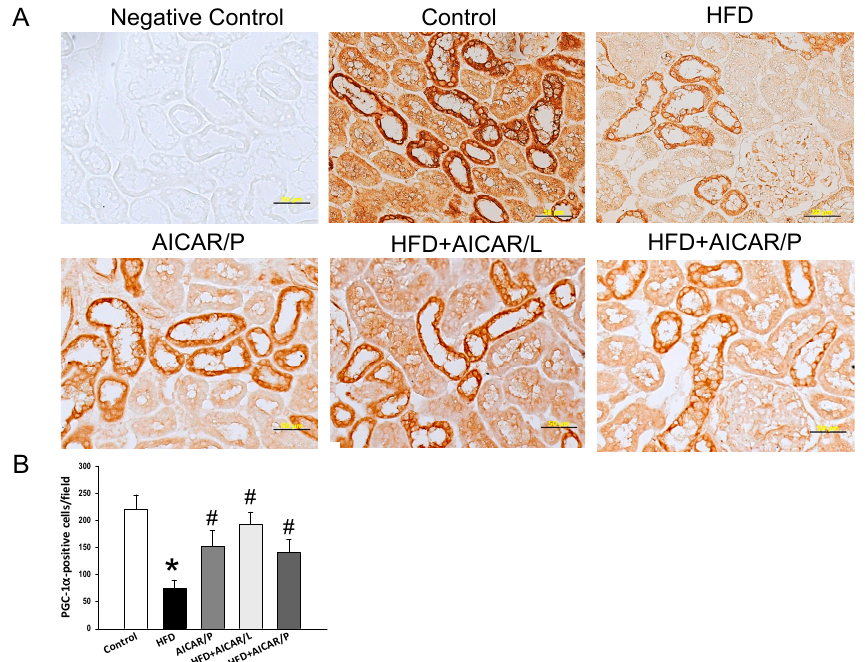
Figure 4. Effect of high-fat diet (HFD) and AICAR treatment in pregnancy (AICAR/P) or lactation (AICAR/L) on mRNA expression of ( A ) silent information regulator transcript 1 (SIRT1) and 4 (SIRT4); ( B ) peroxisome proliferator-activated receptor (PPAR) α -, β -, and γ -isoforms; and ( C ) PPAR γ coactivator-1 α (PGC-1 α ) in 16-week-old male offspring kidneys. * p < 0.05 vs. control, # p < 0.05 vs. HFD, † p < 0.05 vs. AICAR/P, ‡ p < 0.05 vs. HFD + AICAR/L.